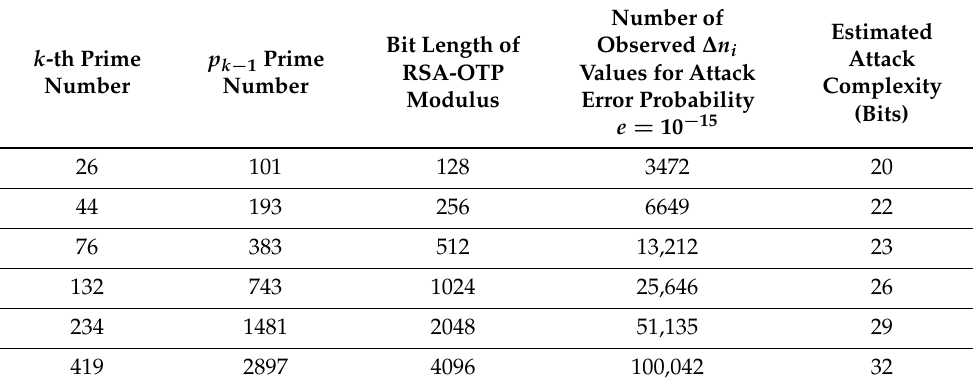
Table 2. hlSummary of the RSA-OTP small prime division